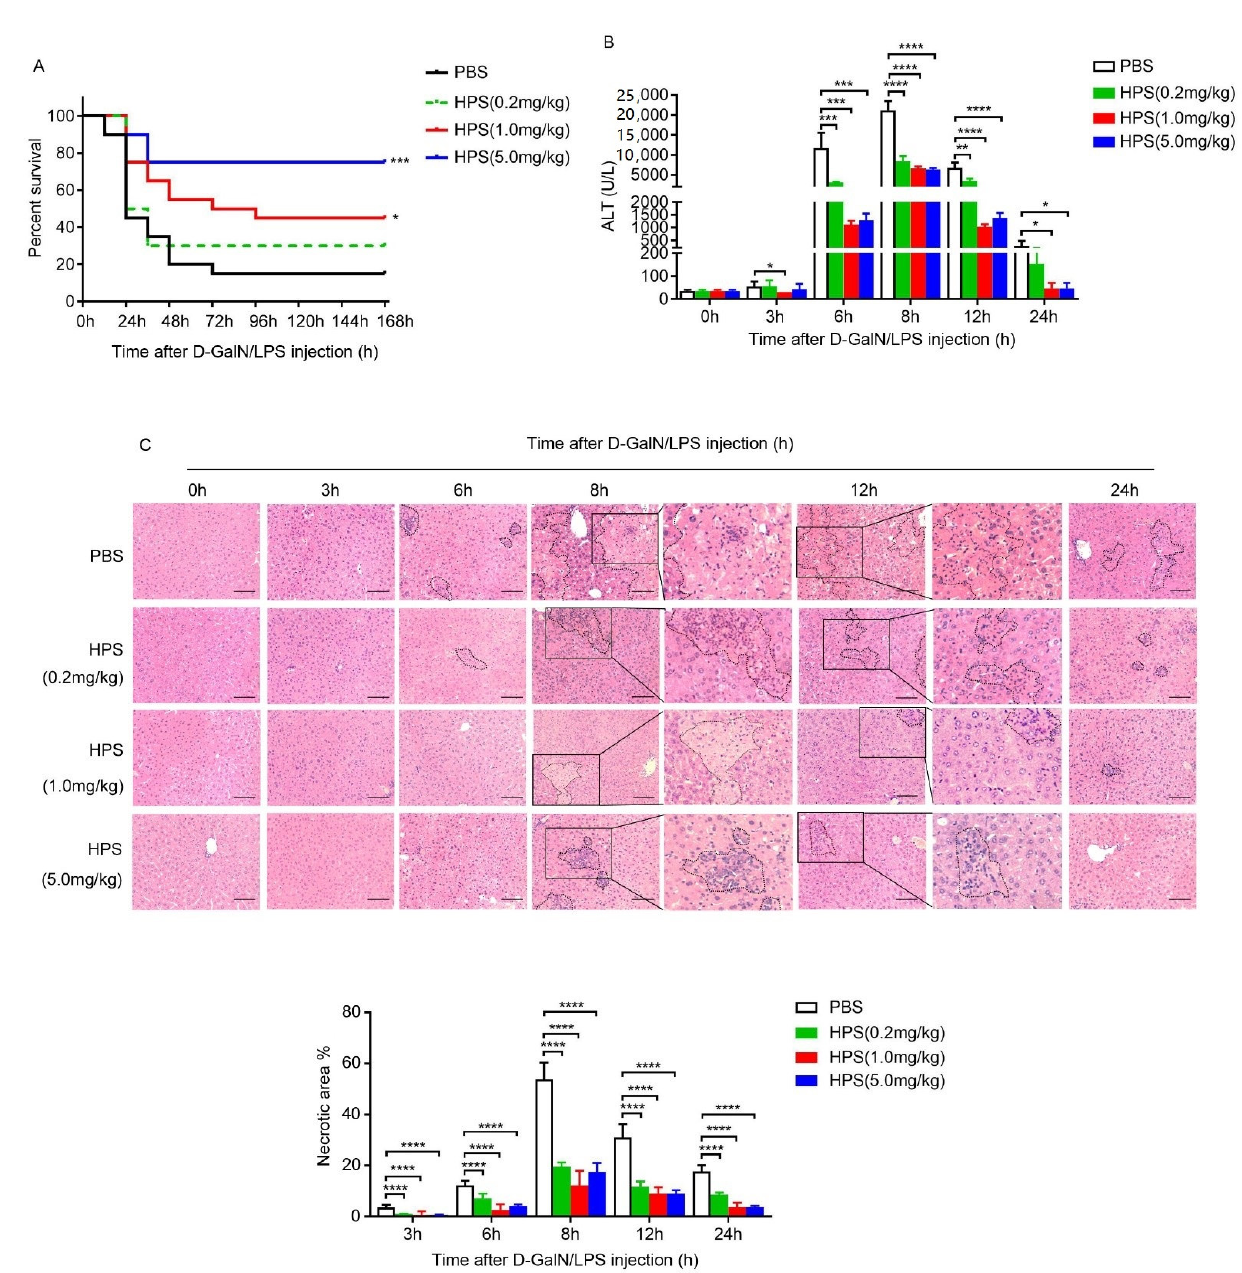
Figure 2. HPS treatment attenuated the damage of D-GalN/LPS-induced liver injury in mice. ( A ) BALB/c male mice at 8 weeks of age were intraperitoneally injected with various amounts of HPS (0.2, 1.0, or 5.0 mg/kg) or PBS 12 h before and 24 and 48 h after D-GalN (1000 mg/kg) and LPS (50 µ g/kg) injection ( n = 10/group). Cumulative survival analysis was determined with a Kaplan–Meier diagram. Log rank test was used to compare the survival distributions between groups (* p < 0.05, *** p < 0.001). For panel ( B ) and panel ( C ), BALB/c male mice at 8 weeks of age were intraperitoneally injected with various amounts of HPS (0.2, 1.0, or 5.0 mg/kg) or PBS 12 h before D-GalN (500 mg/kg) and LPS (20 µ g/kg) injection ( n = 5/group). ( B ) Mice serum ALT levels were detected at indicated time points after D-GalN/LPS injection. Data are represented as mean ± SD. A Student’s t -test was used to compare the mean values between groups. (* p < 0.05, ** p < 0.01, *** p < 0.001, **** p < 0.0001). ( C ) Liver tissues were fixed, sectioned and stained with H&E for histopathological and morphological analysis at indicated time points after D-GalN/LPS injection. Scale bar, 100 µ m. The part enclosed by a dashed line represents the necrotic area. Part of the necrotic area in the 8-h group and 12-h group is enlarged and displayed on the right. The percentage of necrotic area was quantitated using ImageJ software and values are the mean ± SD of five fields of measurements. A Student’s t -test was used to compare the mean values between groups. (**** p <